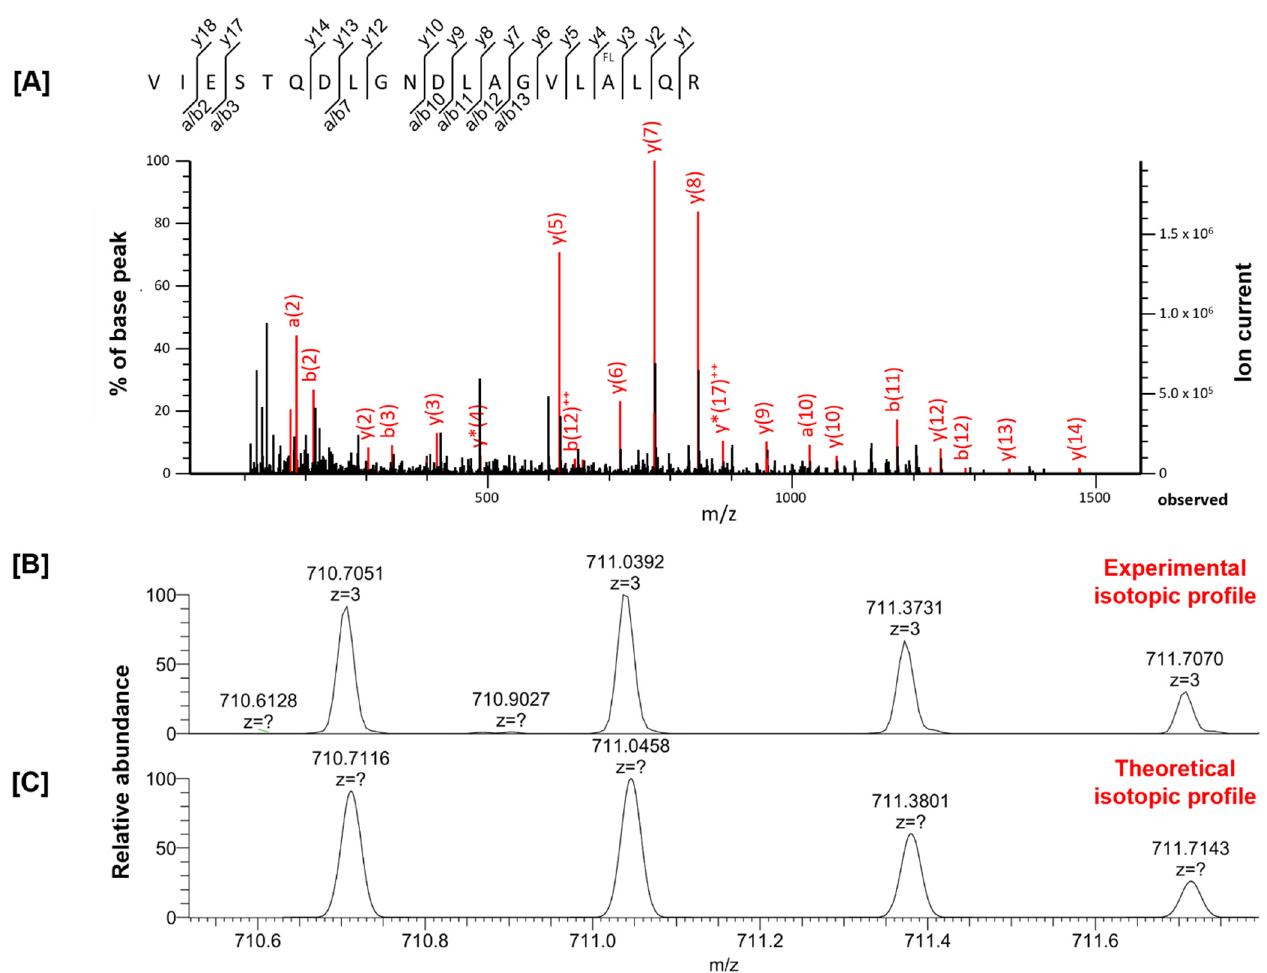
Figure 1. ( A ) Evaluation of MS/MS spectrum for the peptide VIESTQDLGNDLAGVLALQR from the spectrin beta chain, obtained from a brain tissue sample after 21 days of cinacalcet administration. ( B ) Experimental isotopic profile for the peptide VIESTQDLGNDLAGVLALQR. ( C ) Theoretical isotopic profile for the peptide VIESTQDLGNDLAGVLALQR simulated in silico (resolving power: 26 000 FWHM) .